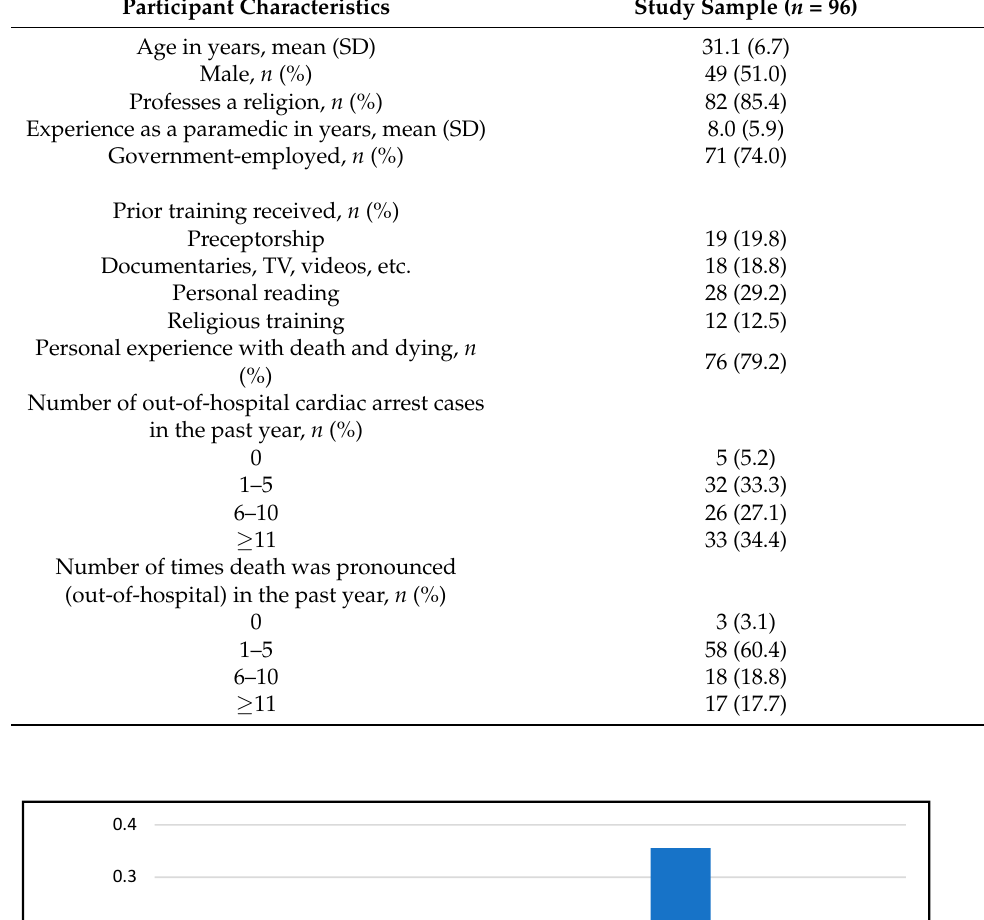
Table 2. Respondents’ characteristics.